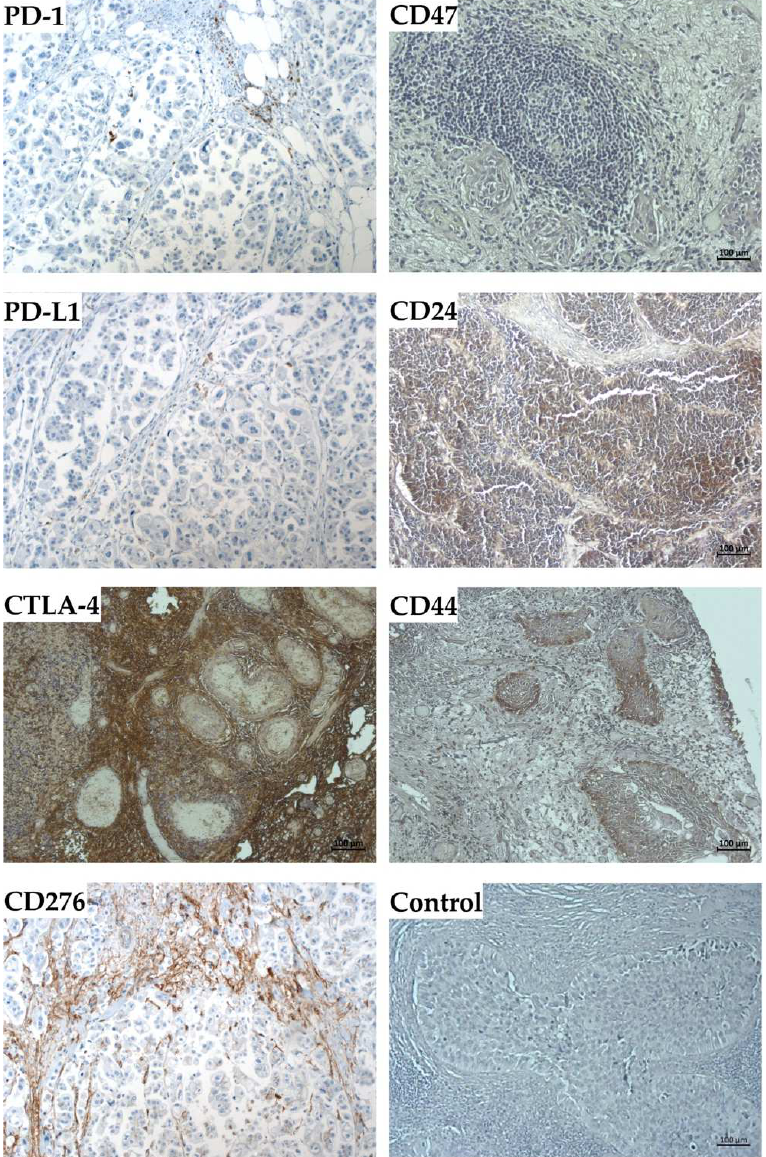
Figure 10. Detection of immune checkpoint antigens and stem-cell markers in bladder cancer tissue. To correlate the expression patterns observed by organoids in vitro with the patho- logical situation in bladder cancer tissue, paraffin sections were stained with antibodies to PD-1, PD-L1, CTLA-4, CD276, CD47, CD24, and CD44 as indicated, and detected by immunohistochemistry. Tissues were counter-stained by HE. Size bars indicate 100 µ